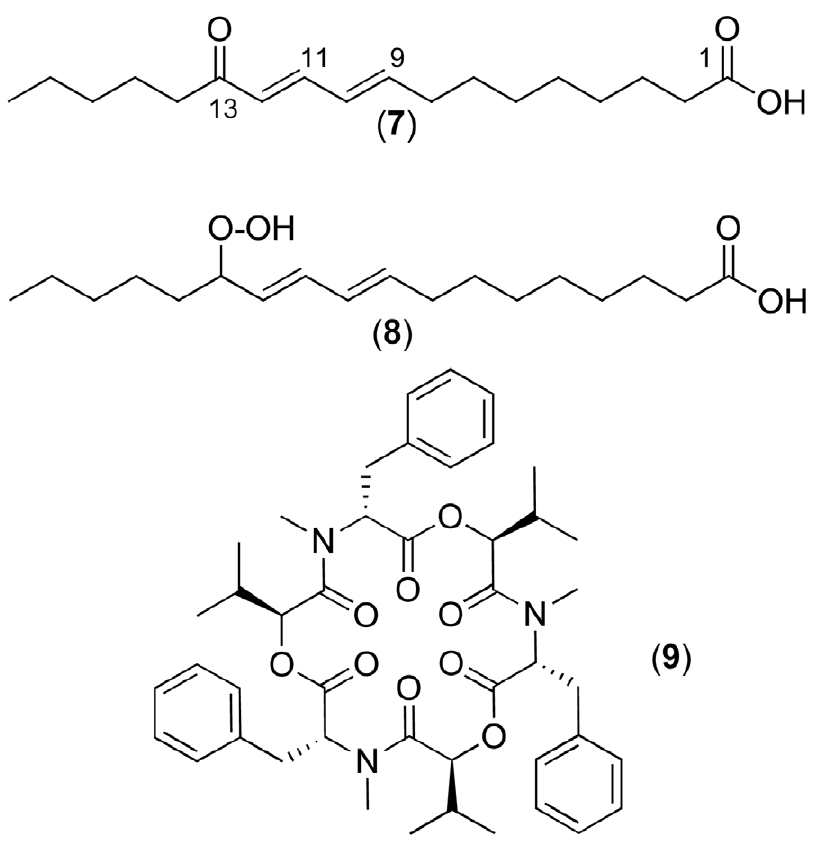
Figure 6. Compounds implied in the chemical communication between the endophyte P. variabile and the phytopathogen